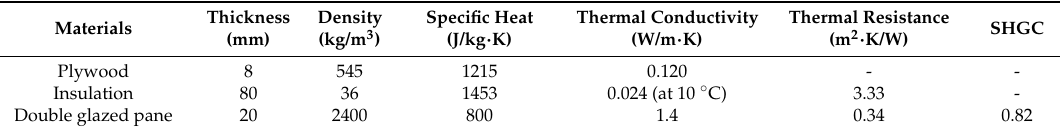
Table 1. Thermal properties of STB materials.